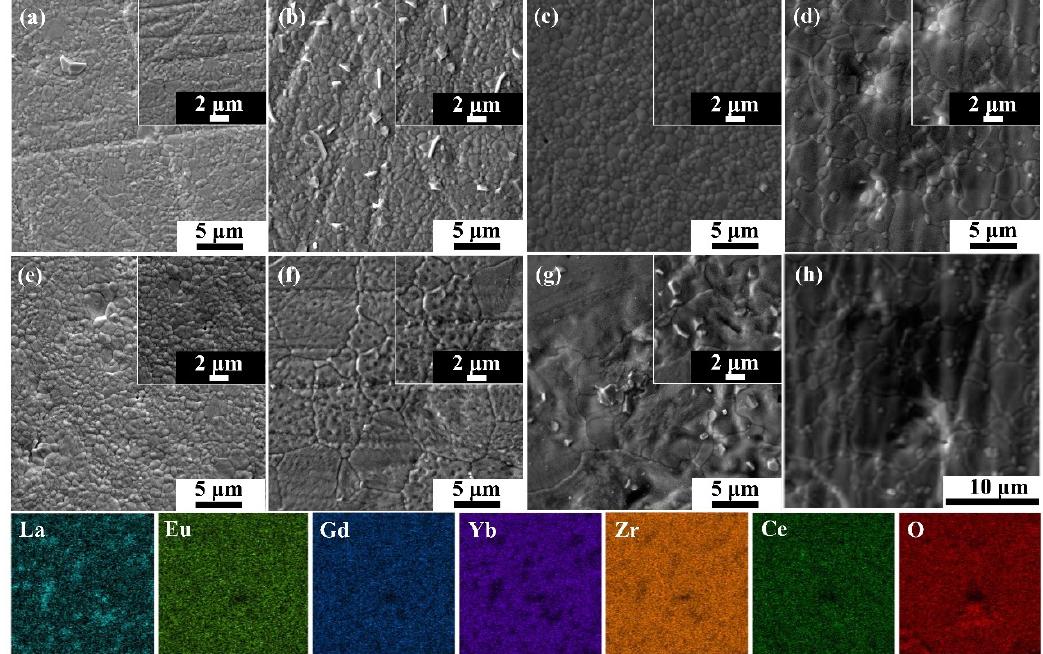
Fig. 4 SEM images of thermally-etched A 2 B 2 O 7 high-entropy ceramics: (a) Hf0.5, (b) Hf0.25, (c) Ce/Hf0, (d) Ce0.05, (e) Ce0.15, (f) Ce0.25, (g) Ce0.5, and (h) SEM–EDS mappings of